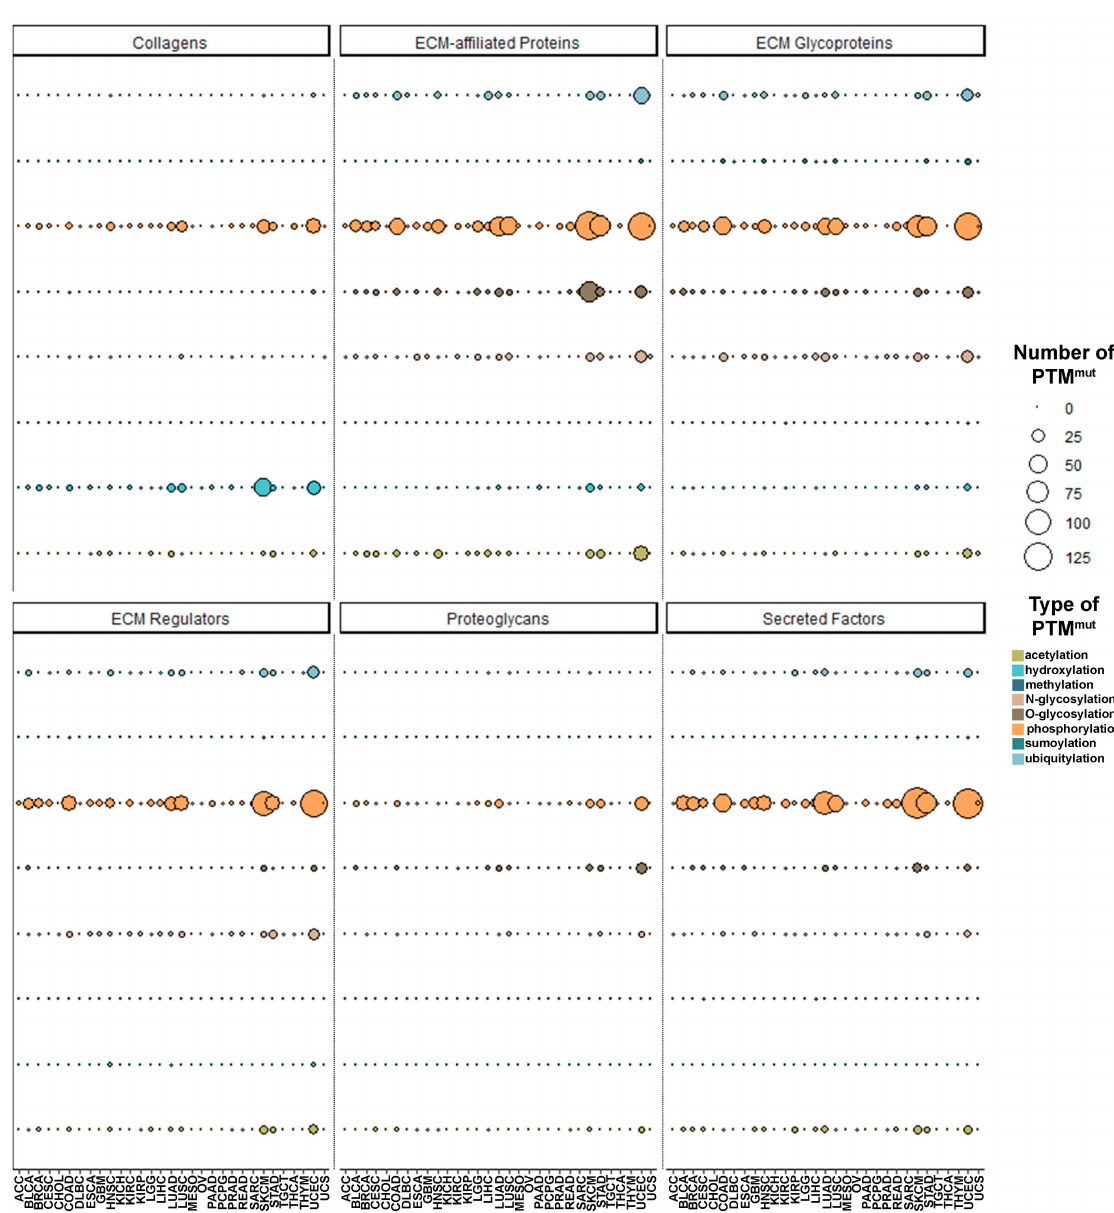
Figure 2. Pan-Cancer abundance and type of PTM mut across the different matrisome families. The abundance (total number) of PTM mut , divided by the different families composing the matrisome and the different types of PTM investigated, is